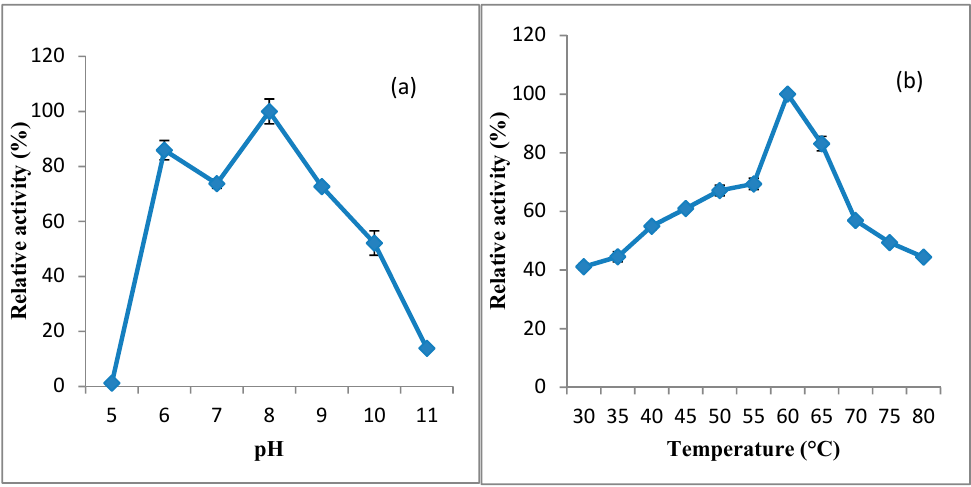
Figure 5. Effect of ( a ) pH and ( b ) temperature on KerBNK1 activity. Each point represents the mean value of triplicate assays.